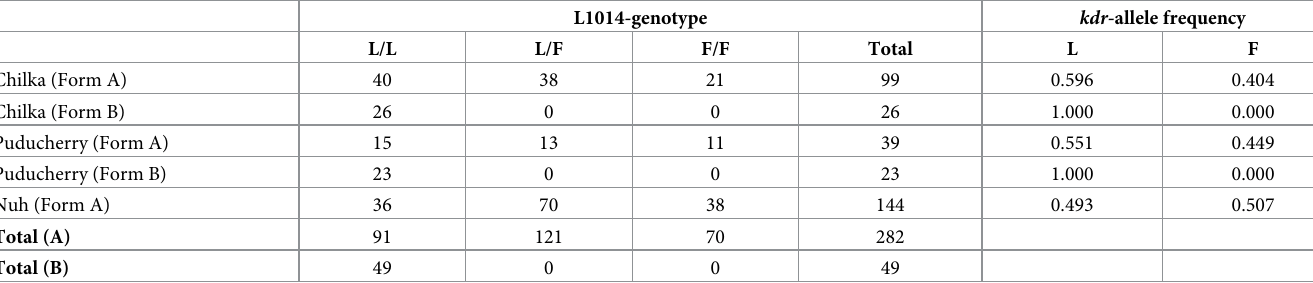
Table 4. L1014- kdr genotyping through PIRA-PCR.